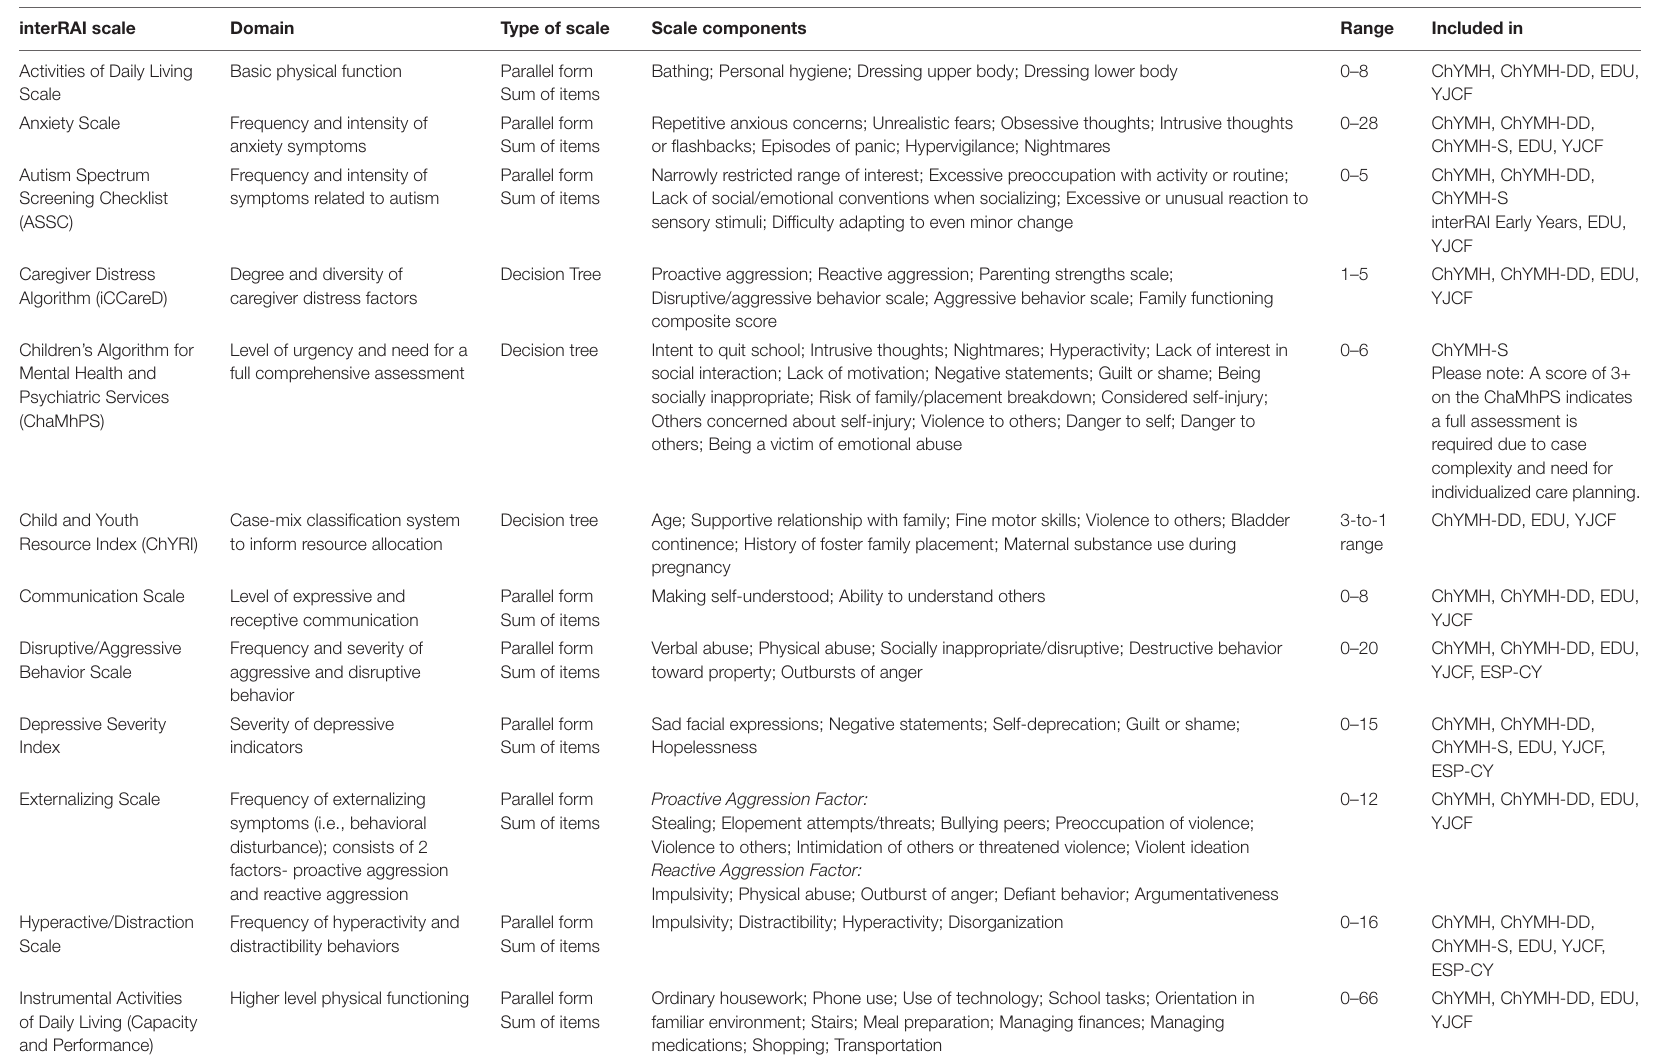
TABLE 2 | Summary of scales and algorithms in interRAI child/youth mental health